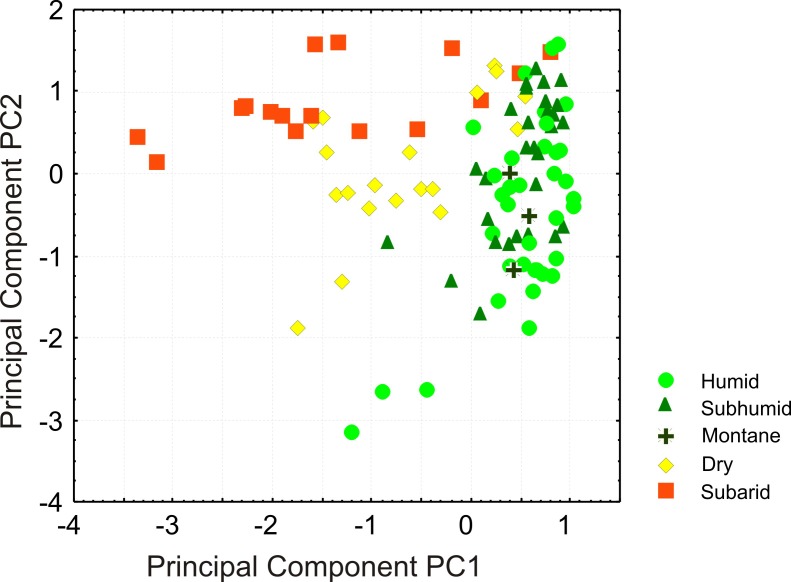
Results of a Principal Component Analysis of surveyed sites in Madagascar.Each dot represents the amphibian and reptile community at one site (see Fig 8 for a map of sites). Colors represent major bioclimatic subdivisions. PCA based on species numbers recorded for each of four major amphibian and eight major reptile groups (Table 1).